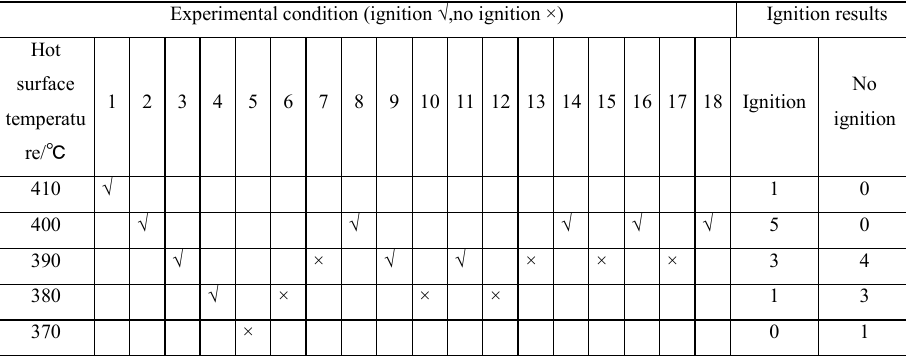
Table 1. Ignition results of aviation fuel on horizontal thermal